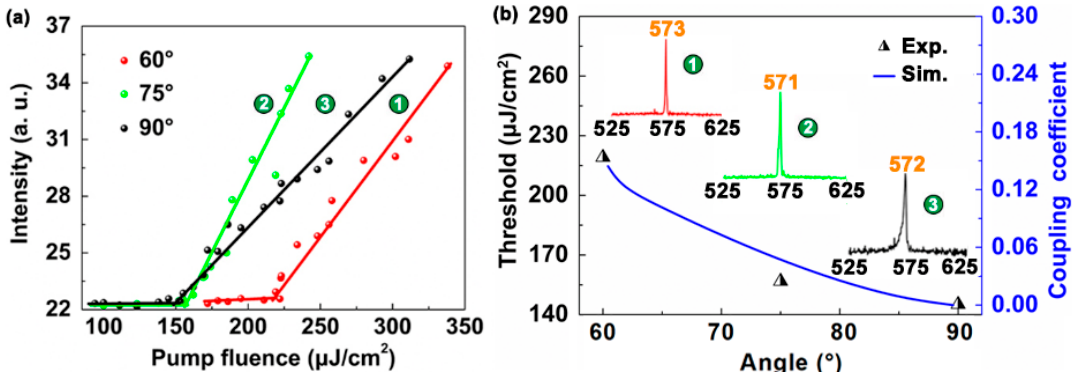
Figure 5. Thresholds of the 2D DFB polymer lasers with different periods. ( a ) Output intensity of 2D DFB polymer lasers as a function of the pump fluence. ( b ) Relationship between the angle θ and the threshold of 2D DFB cavities. The triangles indicate the measured threshold for different 2D DFB polymer lasers. The blue curve denotes the calculated value of the coupling coefficient.